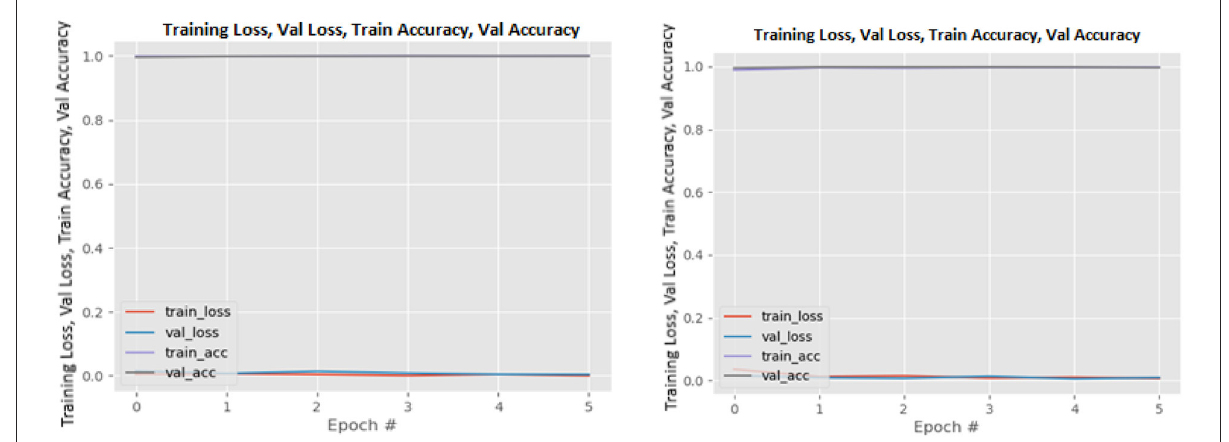
FIGURE19 Xception without data augmentation (left image) and with data augmentation (right